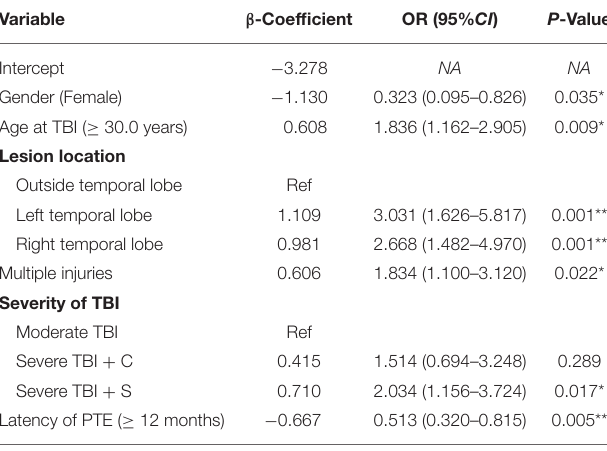
TABLE 3 | Multivariate logistic regression of unfavorable 5-year global functional